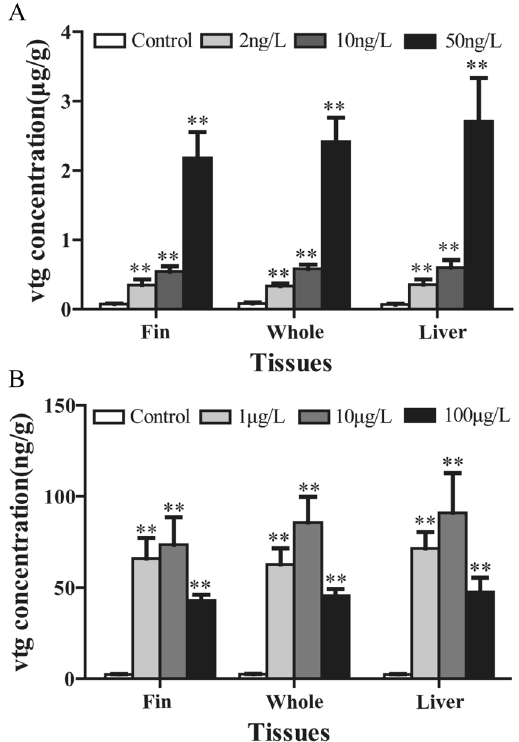
Figure 10. Concentrations of Vtg in guppy exposed to 2, 10, and 50 ng/L EE 2 ( A ) and 1, 10, and 100 μ g/L BPS ( B ) for 21 days. Values are means ± S.D. and asterisks indicate statistically significant difference from the control group ( ** P <